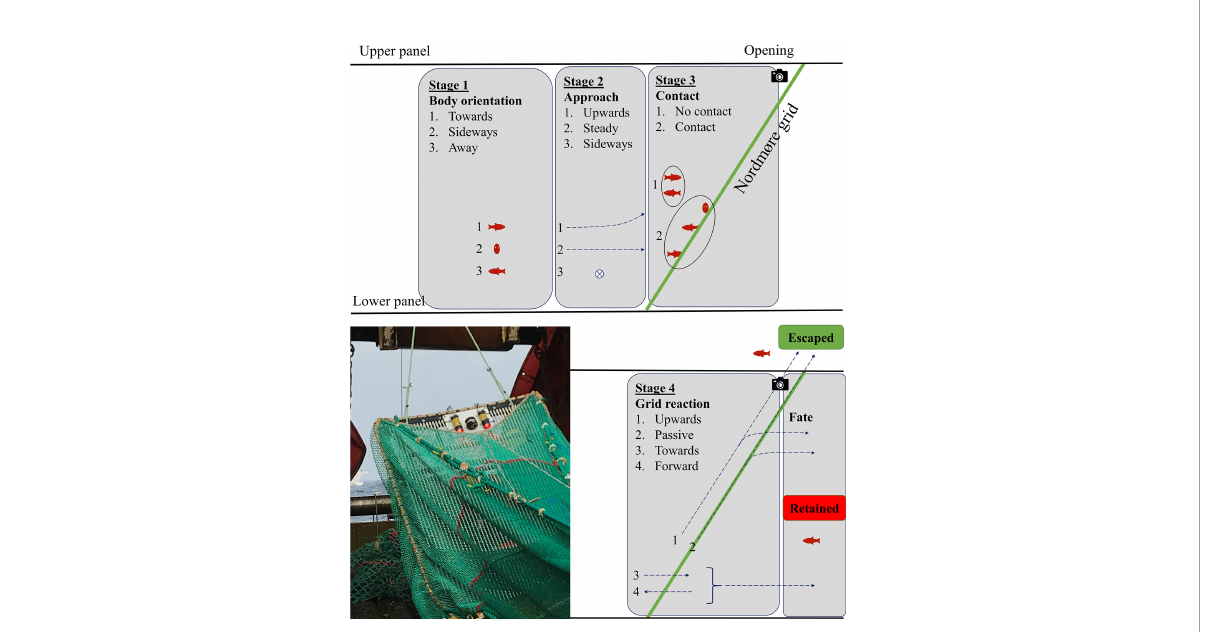
FIGURE 3 Juvenile red fi sh behavioral stages in a Nordmøre grid system. The guiding panel was removed from the image for fi gure readability. An image of the GoPro camera with two Brinyte DIV08W diving torches emitting red light on each side mounted on the 19-mm Nordmøre grid during sea trials is